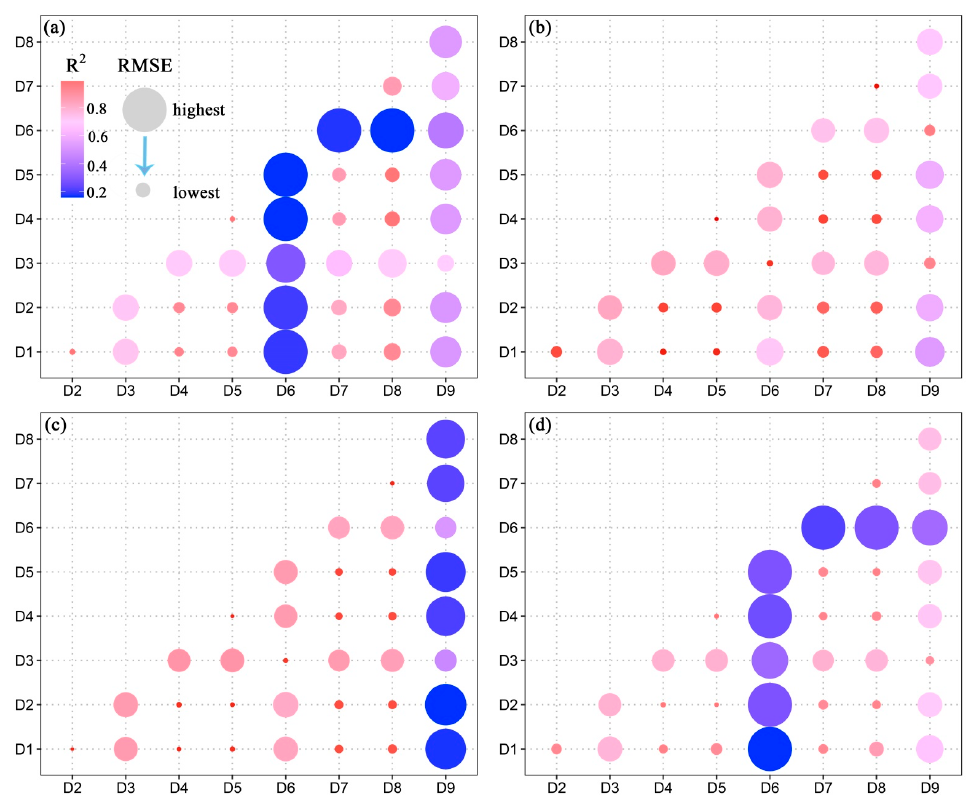
Similarly, the simple linear regression R 2 and the RMSE between each pair of the up-scaled EOSs at each scale are drawn in Figure 12. All linear regression equations pass the F-test at a significance level of 0.001. Unlike the up-scaled SOSs, the up-scaled EOSs are mostly impacted by NDVI filtering methods. The up-scaled EOSs generated from EOSs derived from the SG-filtered NDVI are consistently different from those derived from the AG- and DL-filtered NDVI, with much lower R 2 and relatively large RMSE , especially those from the 500 and 1000 m SG-filtered NDVI. Distinctly, the up-scaled EOSs at 4 km are all closer to each other than at other scales. This indicates that when the scale becomes larger, the up-scaled EOSs become similar then become slightly different.